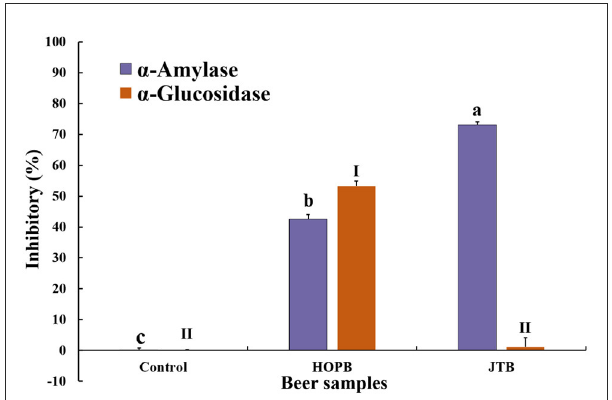
FIGURE8 α -amylase and α -Glucosidase inhibitory effects by the two beers. “a, b, c, and I, II” Different letters in the same indexes indicate significant differences between mean values ( p <